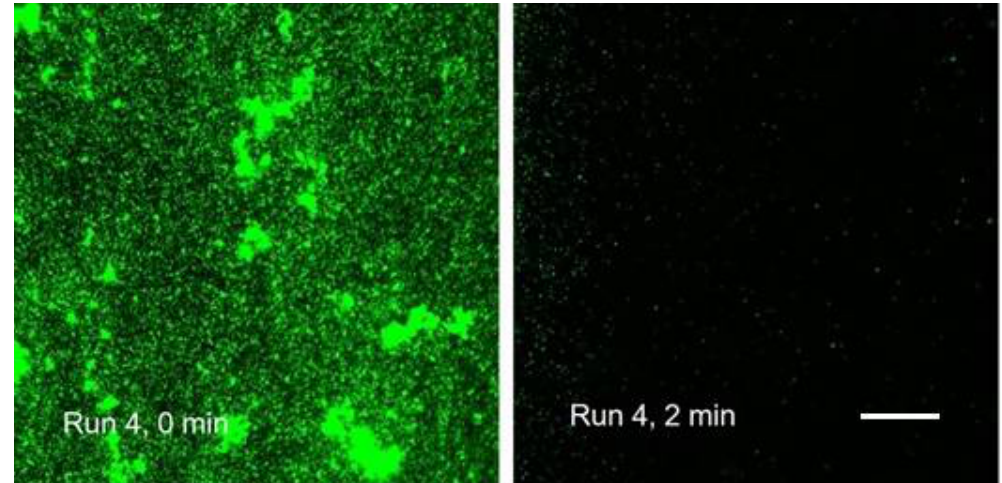
Figure 10. Time-lapse records of PI (red) and Syto 9 (green) fluorescence signal from a mixed biofilm of S. epidermidis and E. coli exposed to Product “A” in four separate assays. Horizontal axis: time in minutes. Vertical axis: % of maximum frame luminance.